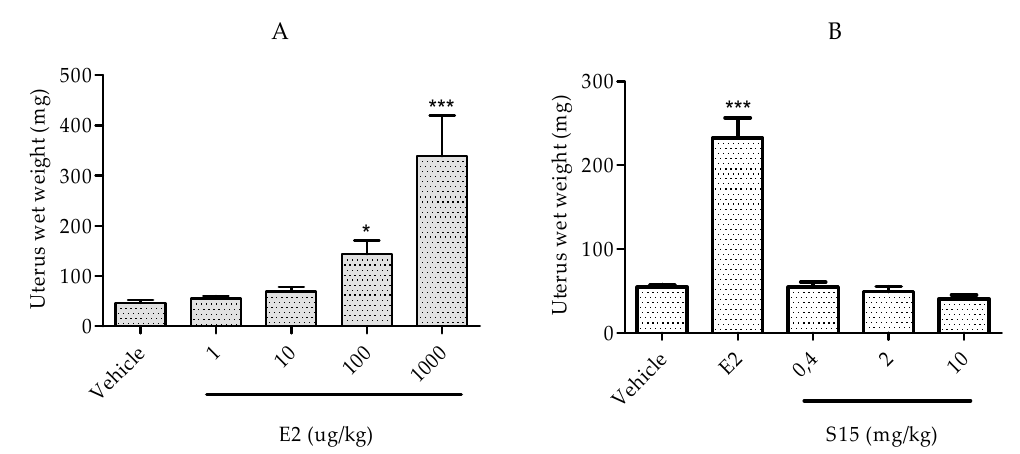
Figure 4. Uterine weight determined by the uterotrophic assay in immature female rats. Different doses of ( A ) E2 and ( B ) Compound S15 or E2 (150 µg/kg) were administered to Post-natal Day (PND) 18 immature rats for three consecutive days. One day after the last dose, animals were sacrificed, and the uterus wet weight was measured. Asterisks indicate statistical differences between the treatment and respective control condition (* p < 0.05 and *** p < 0.001) according to one-way ANOVA and Tukey’s post-hoc test.